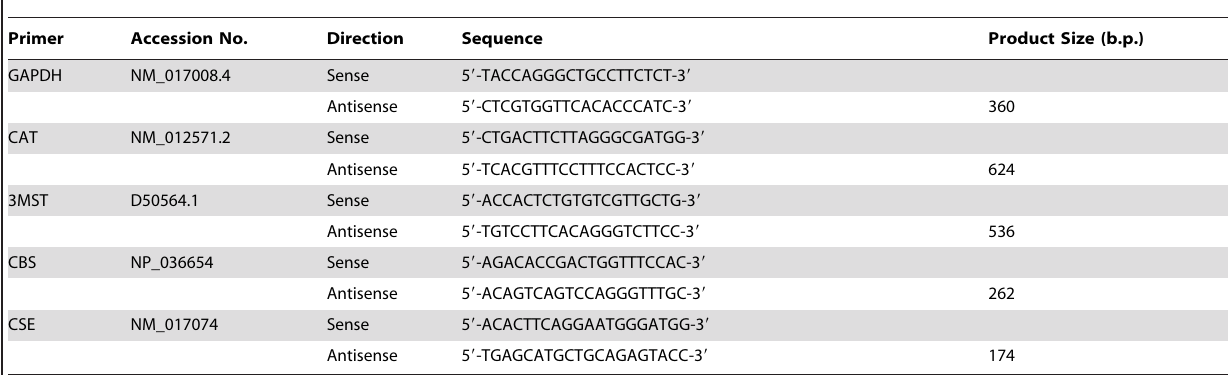
Table 1. Primer sets used for RT-PCR analysis.